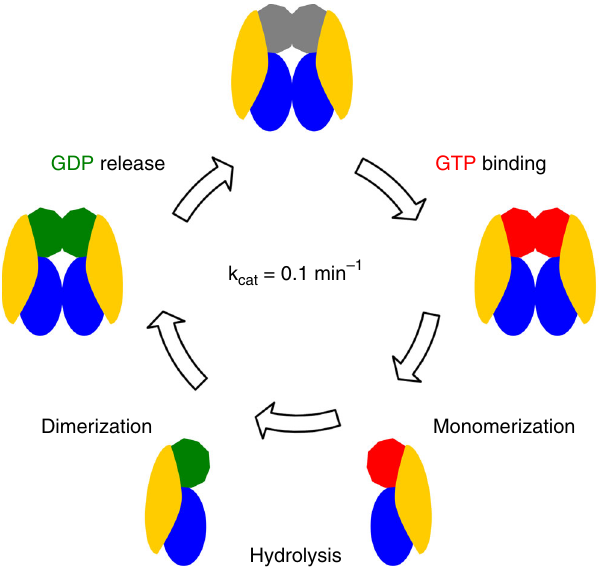
Fig. 6 Proposed monomer-dimer transitions during the GTP hydrolysis cycle of CtRoco. In its nucleotide-free state the protein is dimeric. GTP binding induces conformational changes that lead to fast monomerization. In the monomeric state the protein hydrolyses GTP to GDP. Depending on the protein concentration, protein dimerization could take place either after or before release of GDP. After GDP is released, the cycle can restart. In the cartoon of CtRoco, the LRR domain is coloured yellow , the COR domain blue , the Roc domain dependent on the nucleotide state grey (nucleotide-free), green (GDP-bound) or red